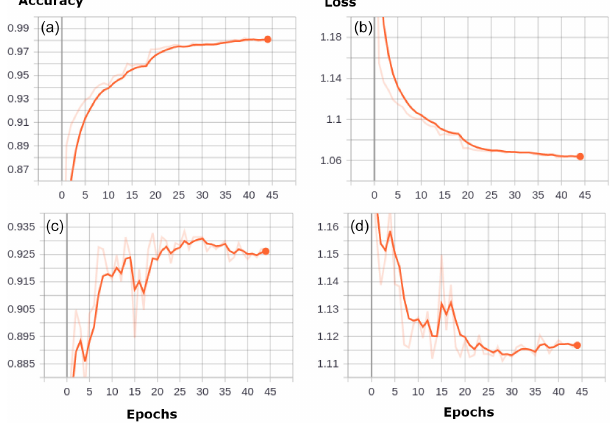
Figure 5. Training (a, b) and validation (c, d) accuracy and loss trajectories. By around epoch 30, the validation accuracy peaks while validation loss bottoms out, and the training loss and accuracy asymptotically reach their minimum and maximum, respectively, which indicates further training may be overfitting the model.